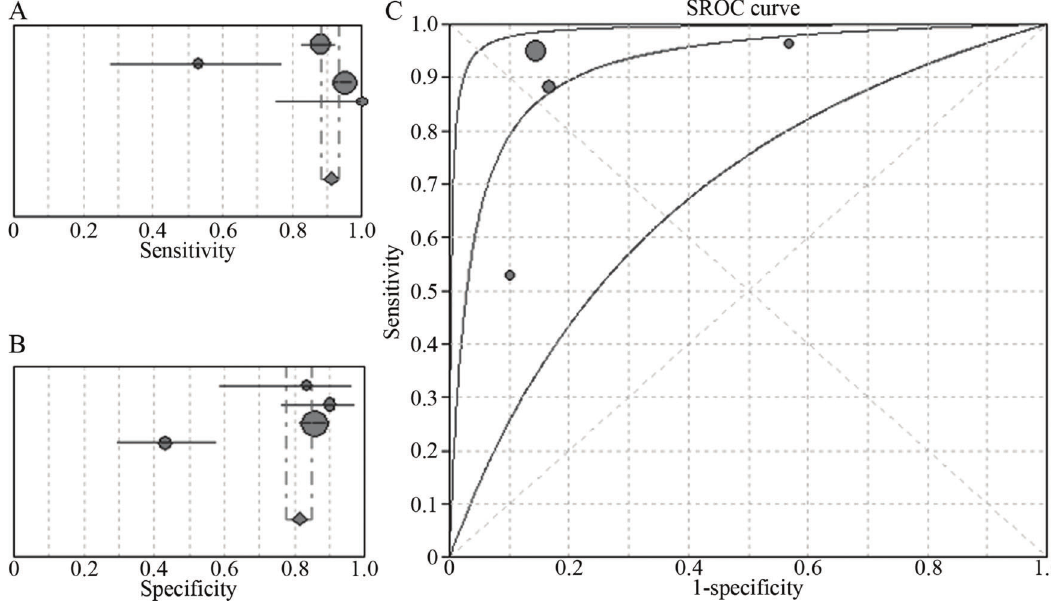
Figure 3 - Four-study analysis of the ability of NBI to diagnose early lung cancer and invasive lung cancer. A. Pooled sensitivity of NBI for the diagnosis of early lung cancer and invasive lung cancer; B. Pooled specificity of NBI for the diagnosis of early lung cancer and invasive lung cancer; C. The SROC curve for the diagnosis of early lung cancer and invasive lung cancer by